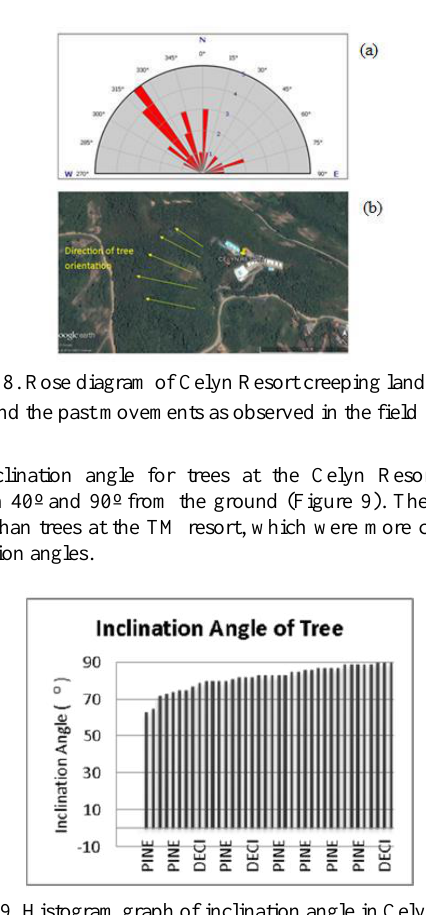
Figure 9. Histogram graph of inclination angle in Celyn Resort plot